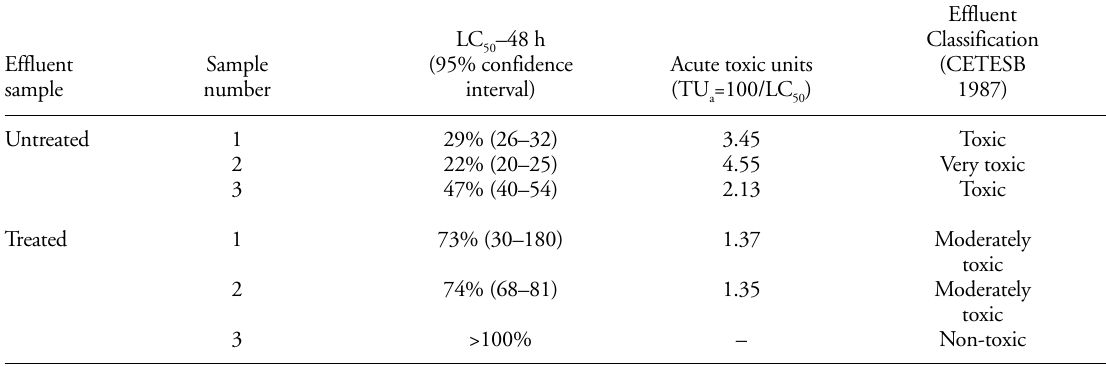
–48 h (%, v/v) and acute toxicity units 50